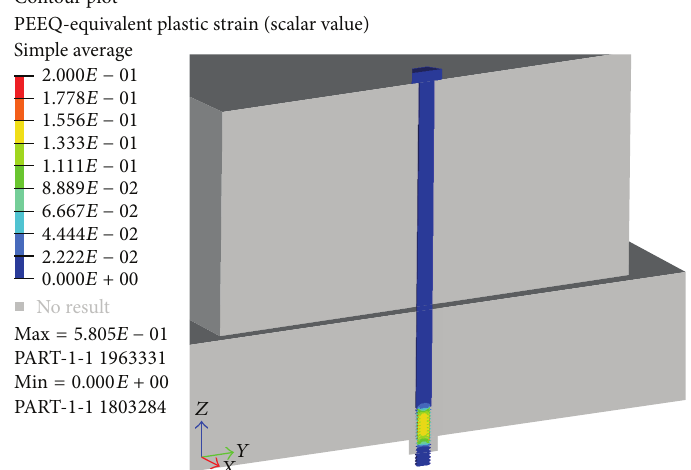
Figure 13: Contours of effective plastic strain at 𝑡 = 150 ms, detailed dynamic tension model.